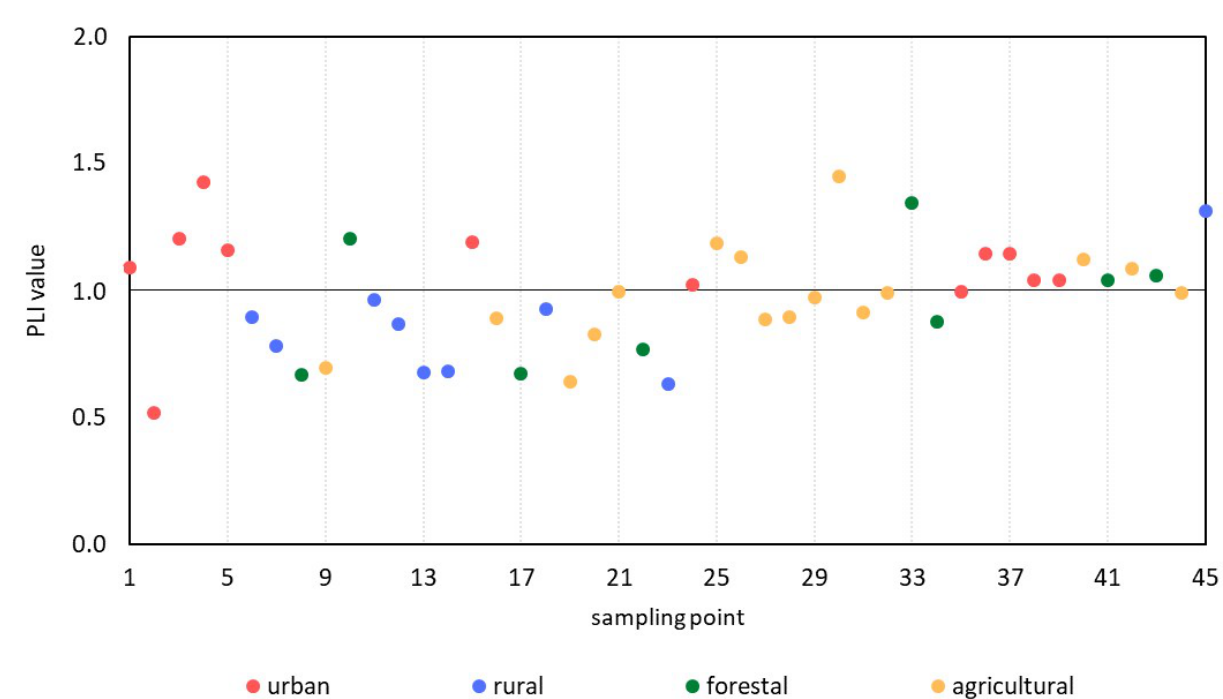
Figure 4. Cross plot of heavy metal PLI in roadside soil.